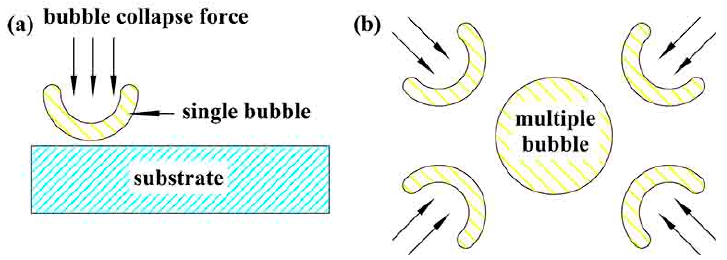
Figure 2. The direction of ( a ) single and ( b ) multiple bubble collapse force.